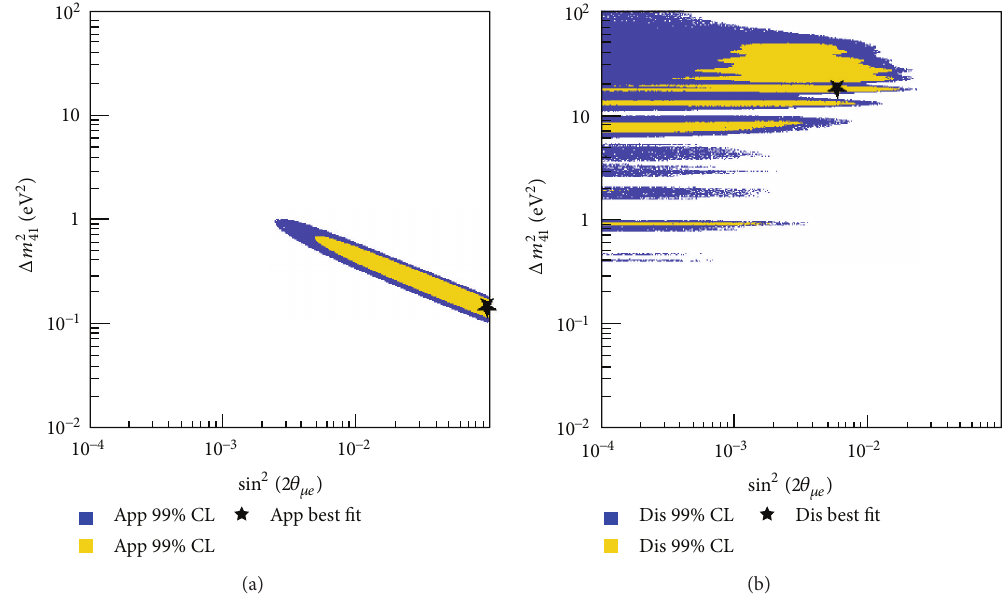
Figure 6: The Δ𝑚 2 41 versus sin 2 2𝜃 𝜇𝑒 allowed space from fits to appearance (a) and disappearance (b) data in a ( 3 + 1 ) model.